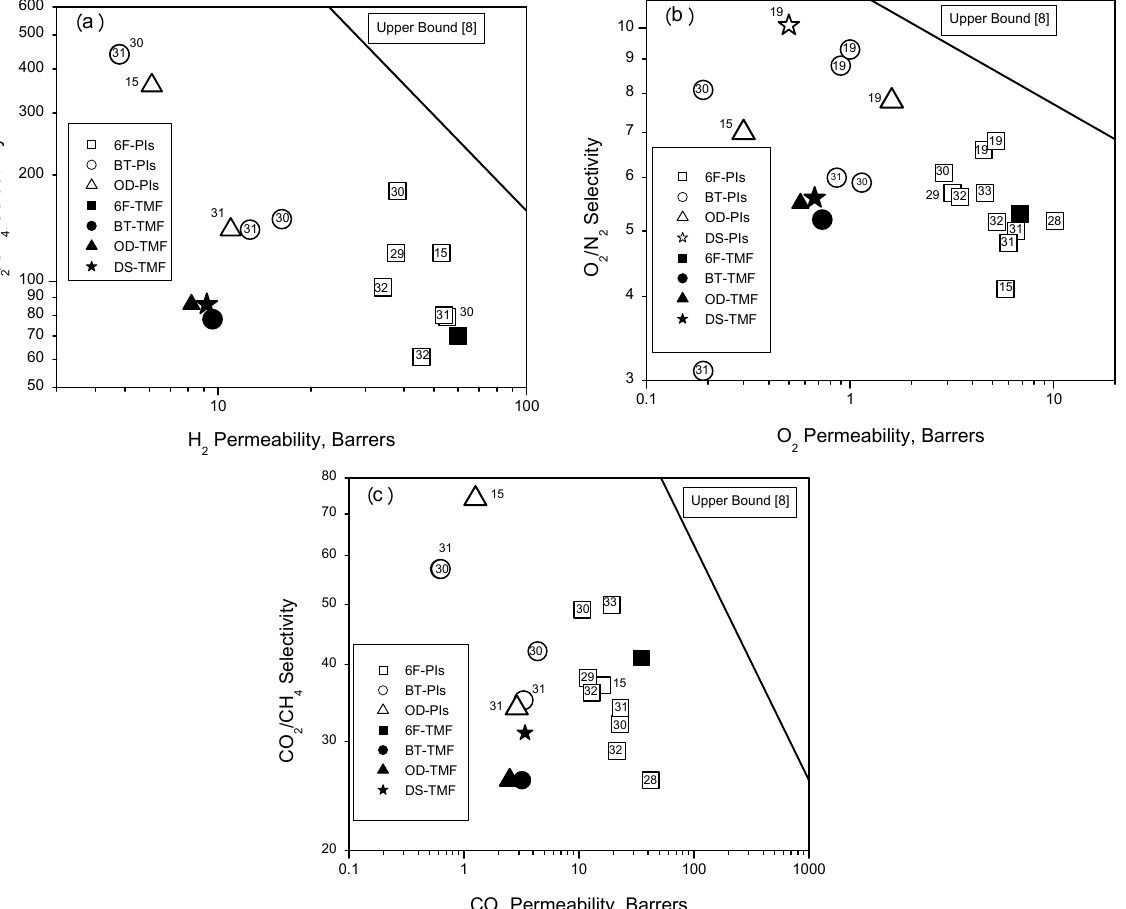
Figure 6. Selectivity and gas permeability combination of properties measured for the membranes based on the polyimides synthesized in this work: H 2 /CH 4 ( a ); O 2 /N 2 ( b ); and CO 2 /CH 4 ( c ). Black or closed symbols correspond to PI membranes synthesized in this work, whereas open symbols are values reported